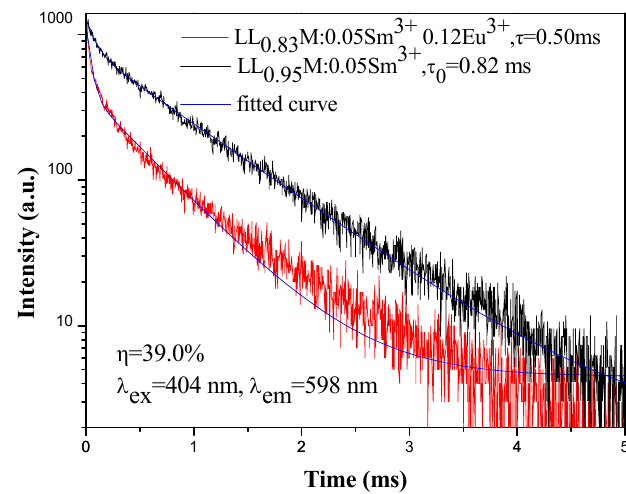
Figure 8. Decay curves of 4 G 5/2 Sm 3+ luminescence of LLM:0.05Sm 3+ and LLM:0.05Sm 3+ ,0.12Eu 3+ , under the excitation of 403 nm and monitored at 598 nm. The luminescent lifetimes ( τ ) and the energy transfer efficiency from Sm 3+ to Eu 3+ are indicated.